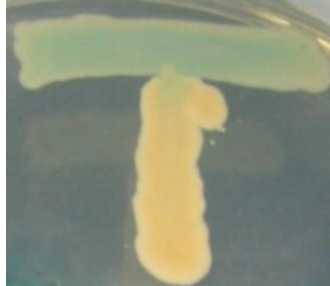
Figure 2. Cross streak of strain T2-2 colony with Agrobacterium tumefaciens NTL4 (pZLR4). Bacterial isolate T2-2 (vertical streak) were cross streaked with A. Tumefaciens NTL4 (pZLR4) (horizontal streak) to detect the presence of AHL production. Blue pigmentation indicated the presence of AHLs production by